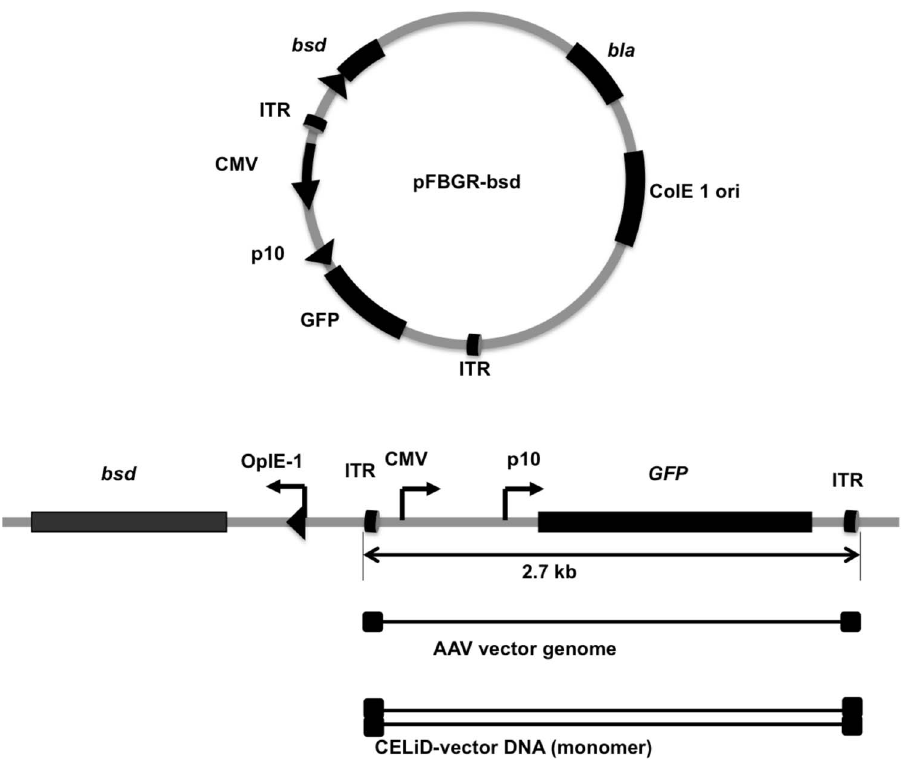
Figure 1. Schematic representation of plasmid DNA used for producing stable cell lines. Plasmid pFBGR-bsd contains the GFP gene under the dual control of the cytomegalovirus IE promoter (CMV) and baculovirus p10 promoter (p10) flanked by AAV-2 inverted terminal repeats (ITR). bla , b -lactamase (ampicillicin-resistance gene). bsd , blasticidin-S deaminase gene. ColE1, bacterial origin of replication. (Lower) Linear illustration of pFBGR-bsd indicates the rescued forms of the ITR-flanked transgene. The linear, single-stranded AAV virion genome is represented by a solid thin line flanked by the inverted terminal repeats (ITRs, filled rectangles). The duplex CELiD-vector DNA is represented by the open rectangle flanked by AAV